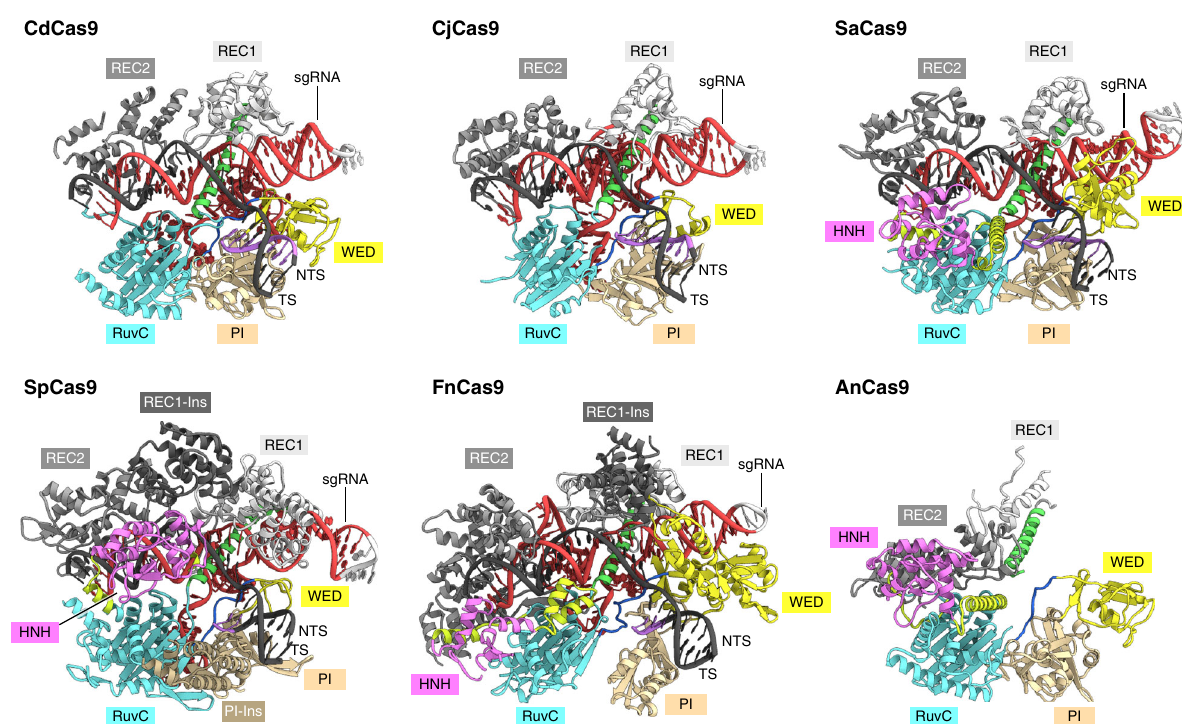
Fig. 3 Structural comparison of the Cas9 orthologs. The structures of Corynebacterium diphtheriae Cas9 (CdCas9), Campylobacter jejuni Cas9 (CjCas9) (PDB: 5X2G), Staphylococcus aureus Cas9 (SaCas9) (PDB: 5CZZ), Streptococcus pyogenes Cas9 (SpCas9) (PDB: 4UN3), and Francisella novicida Cas9 (FnCas9) (PDB: 5B2O) bound to their cognate single-guide RNA (sgRNAs) and target DNAs, and the structure of Actinomyces naeslundii Cas9 (AnCas9) in the apo form (PDB: 4OGE). The bridge helix and the linker regions are colored green and light green,